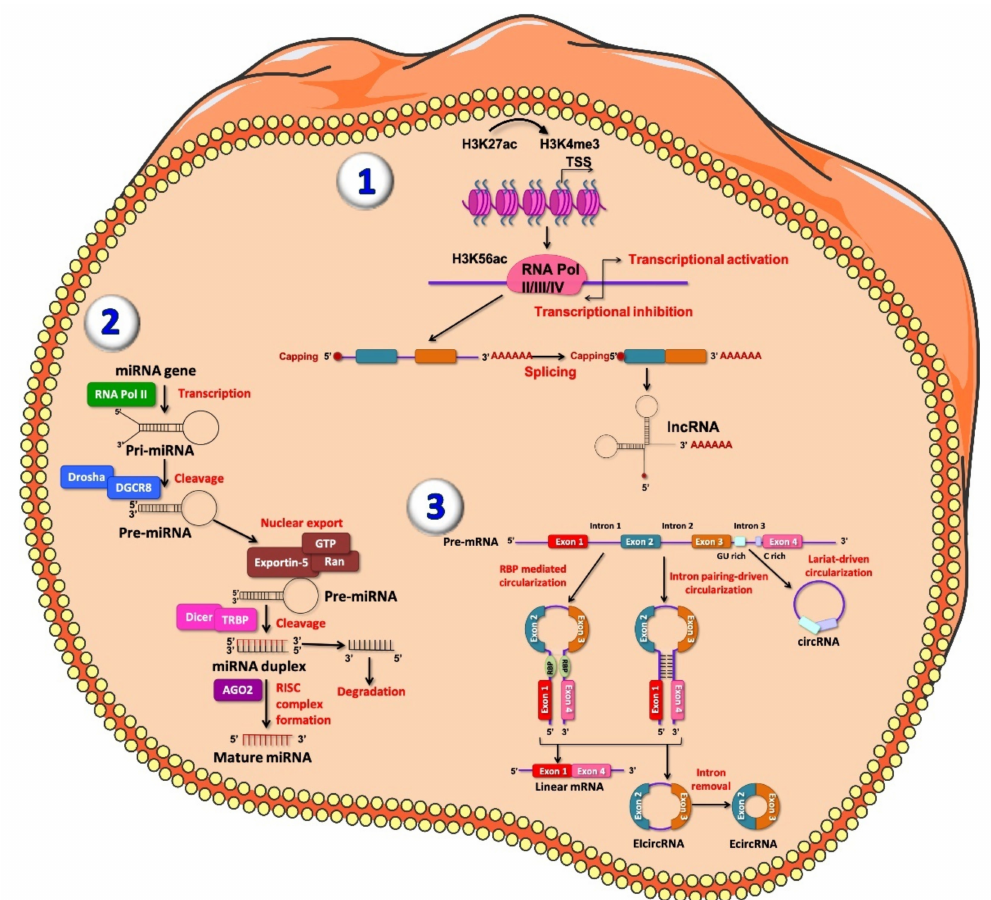
Figure 1. Representative figure of long non-coding RNAs (lncRNAs) ( 1 ), microRNAs (miRNAs) ( 2 ) and circular RNAs (circRNA) ( 3 ) biogenesis. ( 1 ) At the chromatin state, H3K27ac and H3K4me3 are enriched at lncRNA promoter; transcription of lncRNA is initiated from different promoters in antisense direction, enriched for H3K56ac and Pol II/III/IV. The resulting pre-mature lncRNA is subjected to a 3 (cid:48) -polyadenylated and the 5 (cid:48) -end capping with methyl-guanosine. Then, all introns are spliced, resulting in a final mature lncRNA. ( 2 ) MiRNAs are firstly transcribed by RNA polymerase II into the nucleus, producing primary miRNAs (pri-miRNAs), a stem loop shaped RNA sequence. Pri-miRNA, once processed, is recognized and cleaved by the multi-protein complex Microprocessor within the nucleus. This complex is composed by two double- stranded molecules: RNase III enzyme DROSHA and RNA-binding protein DGCR8. DROSHA cuts, by its RNase III domains, in two different points of the double strand RNA (dsRNA) towards the base of the stem-loop generating a ~70 nucleotide hairpin–shaped precursor miRNAs (pre-miRNAs), showing an overhang at the 3 (cid:48) end of 2 nucleotide left by the asymmetrical cut made by DROSHA recognized by Exportin-5 which carries the pre-miRNA into the cytoplasm. Here, the pre-miRNA is further processed by DICER/TRBP complex, which generates imperfect duplexes of 22 nucleotides containing a guide strand and a passenger strand. The guide strand (represented in red) together with Argonaute proteins forms RNA-induced silencing complex (RISC) and generates the mature miRNA, while the passenger strand is finally degraded. ( 3 ) CircRNAs are generated by an alternative splicing mechanism of pre-mRNA, termed back-splicing. In this process, the 3 (cid:48) -end of an exon binds to the 5 (cid:48) -end of its own or to an upstream exon through a 3 (cid:48) ,5 (cid:48) - phosphodiester bond, forming a closed structure with a back-splicing junction site. Two models of circRNAs biogenesis have been described: the lariat model and the direct back-splicing model, further subdivided into RBP-mediated circularization and Intron pairing- driven circularization, regulating adjacent splice sites [52]. Lariat-driven circularization occurs through the interaction between the 3 (cid:48) hydroxyl of the upstream exon with the 5 (cid:48) phosphate of the downstream exon generating a covalent binding, producing a lariat containing both exons and introns. From both RBP-mediated circularization and intron pairing-driven circularization four main subtypes of circRNAs have been identified: exonic-circRNAs (ecircRNAs), mainly derived from single or multiple exons and exonic-intronic circRNAs (EIciRNAs), which consist of both introns and